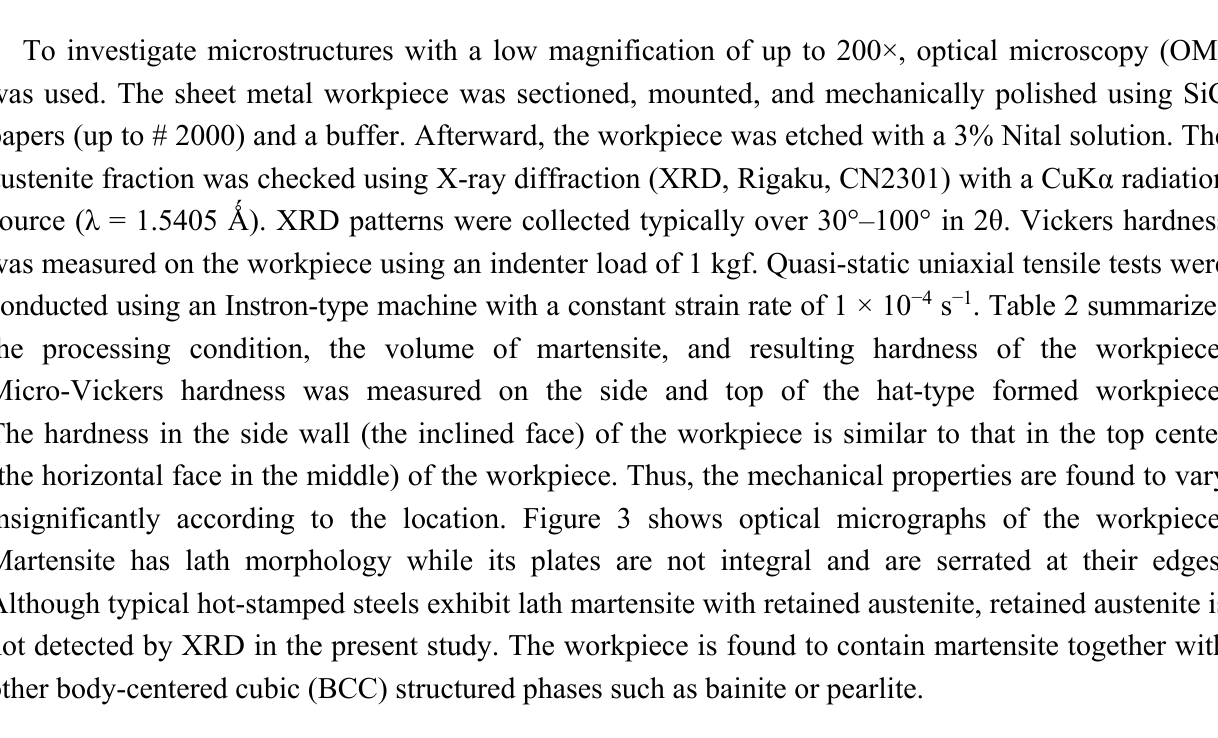
Table 2. The processing conditions and mechanical properties of the